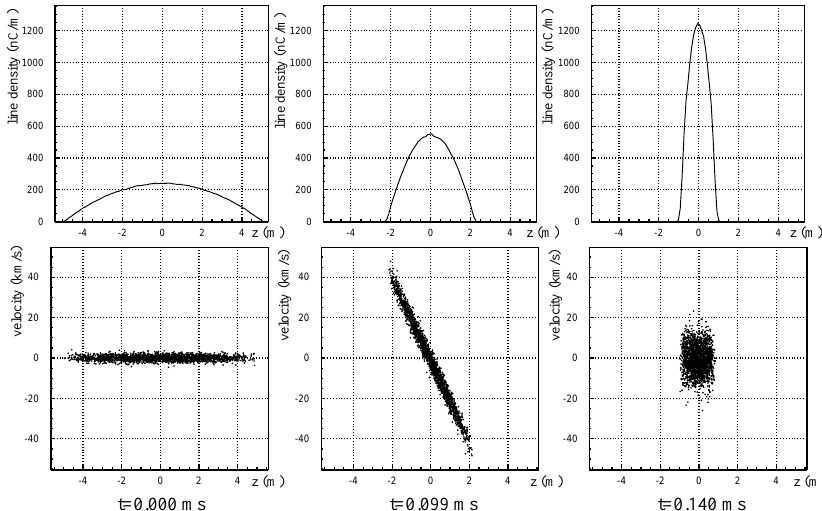
FIG. 11. Line density and scatter plot of longitudinal phase space for a semiparabolic bunch with h (cid:1) 2 0.005 .